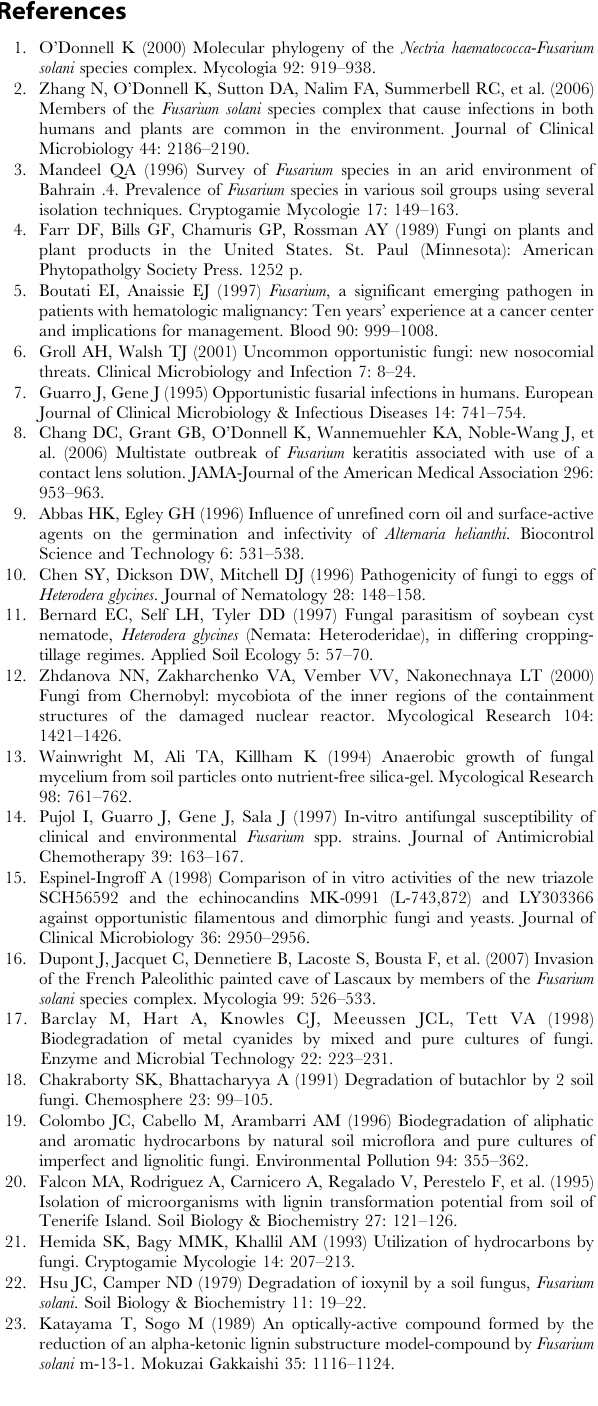
Table S13 Distribution of Small Secreted Proteins (SSP) among filamentous Ascomycetes as identified by